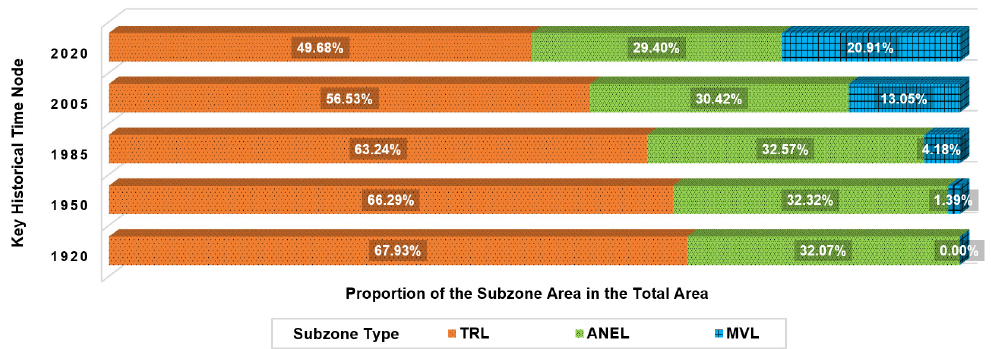
Figure 7. Historical proportions of each subzone area in the total area of the TAL Core Zone.